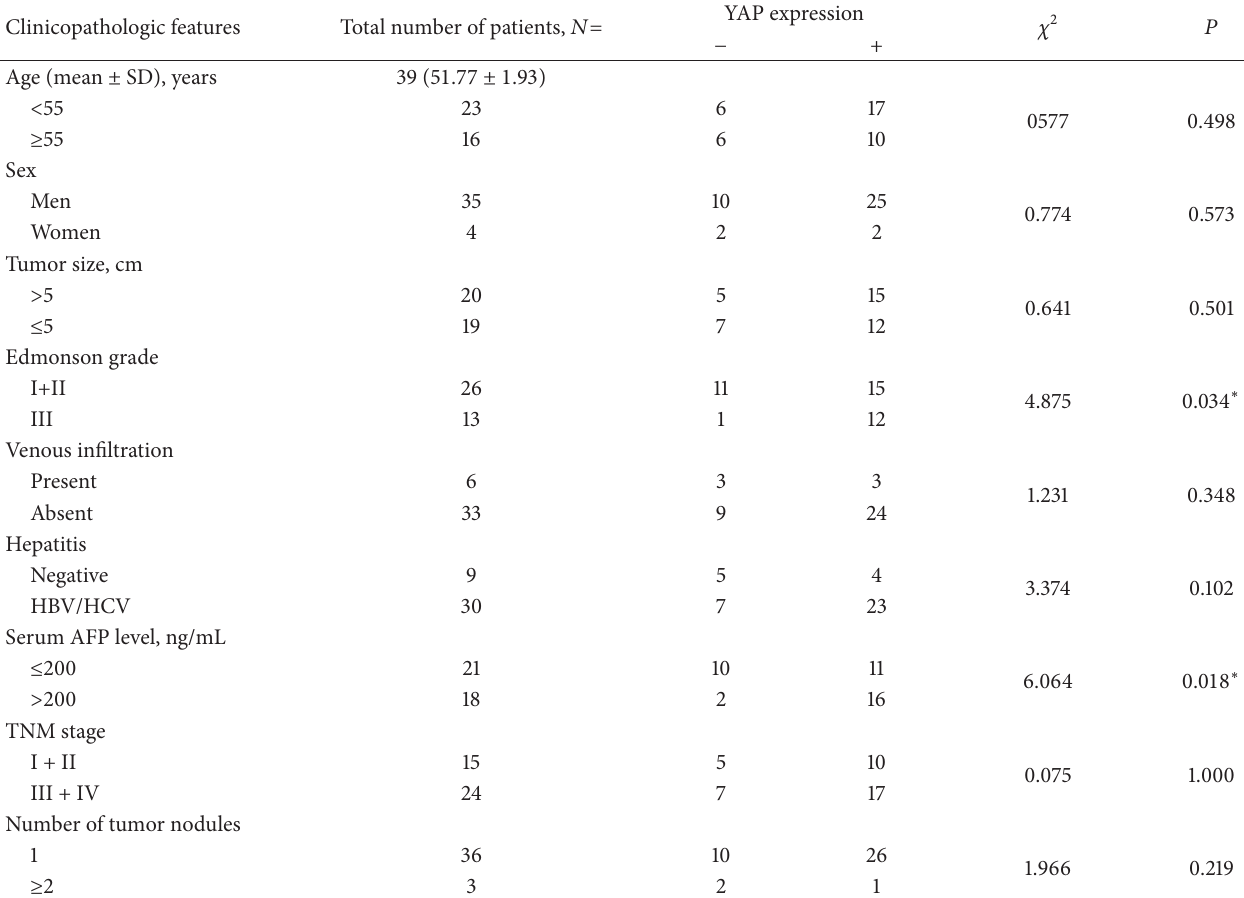
Table 1: Clinical correlation of YAP expression in